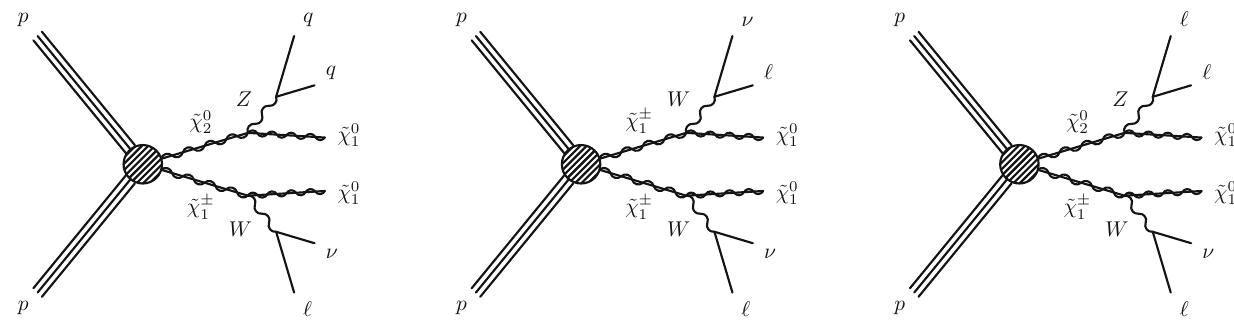
Fig. 1 The simplified model used for the optimisation of ATLAS and CMS searches targeting on-shell W and Z production. Neutralinos and charginos are pair-produced, resulting in final states with leptons, jets and missing energy